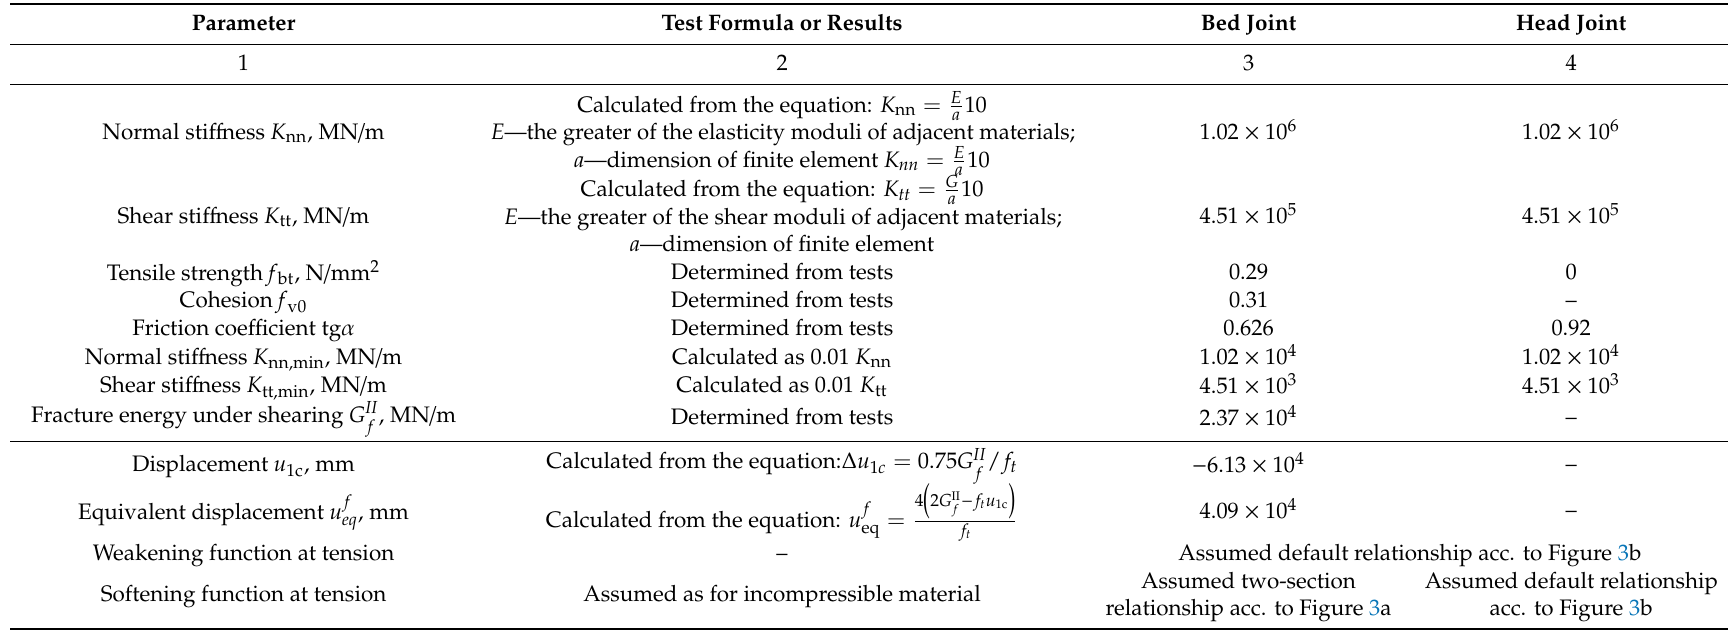
Table 5. Parameters of contact elements taken for modelling autoclaved aerated concrete (AAC) walls.